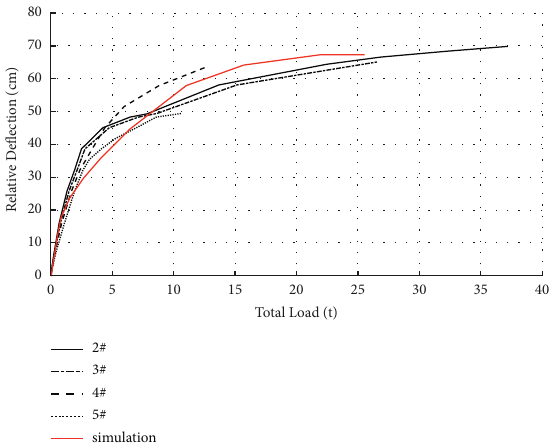
Figure 11: Contrast diagram of midspan deflection (simulated value of beam 2# and the unfired beam).